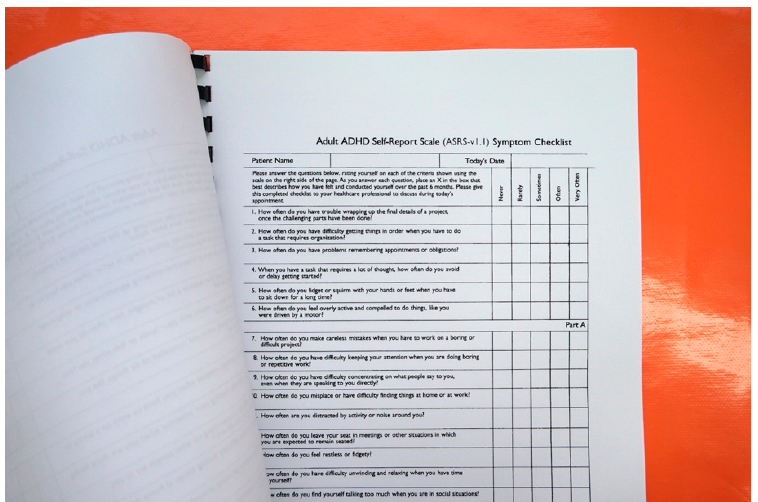
Figure 7. The standard diagnostic form used by the NHS to determine whether a patient requires a referral for Psychiatric assessment, which is also deployed before each subsequent visit after diag-